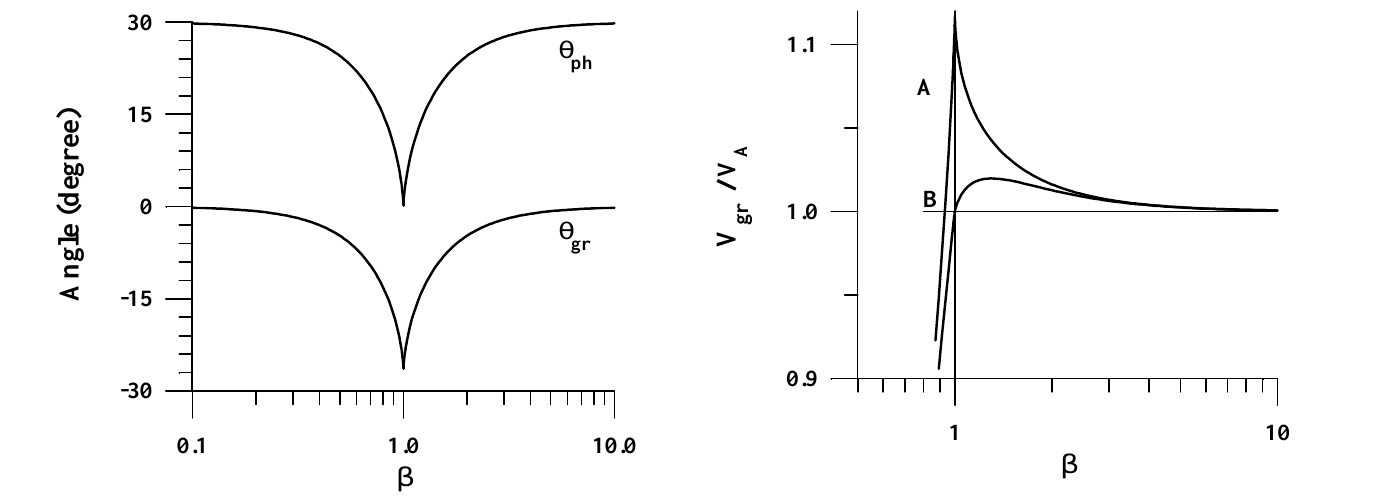
Fig. 4. Angle θ ph (between the wave vector of slow magnetoa- coustic mode and external magnetic field) at which the group ve- locity has a maximal value, and the angle θ gr (between the maxi- mal group velocity and external magnetic field) as a function of the β -parameter, which is shown in the logarithmic scale.